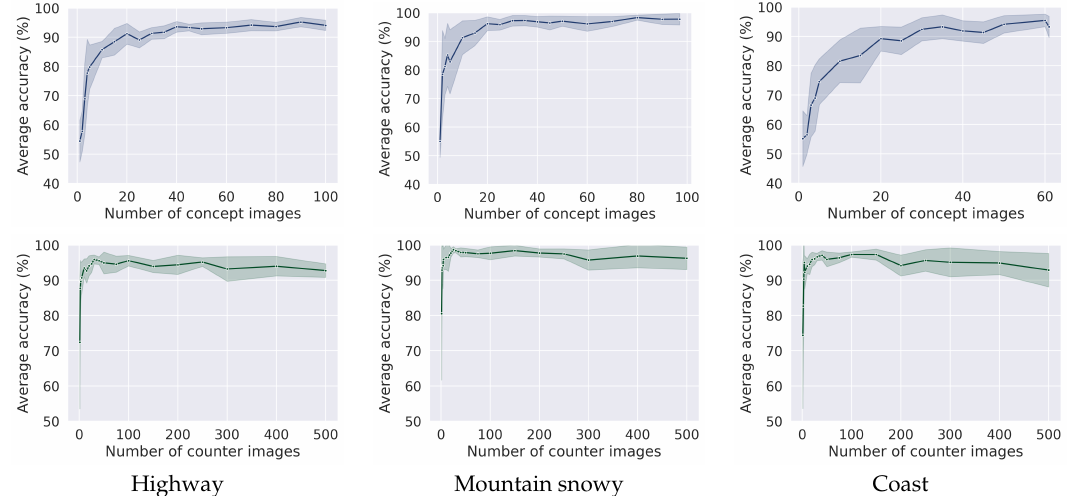
Figure 5. CAV average accuracy of concepts highway, mountain snowy and coast with a varying number of concept images (top row) and counter images (bottom row). The shadowed band indicates the standard deviation over the ten runs.